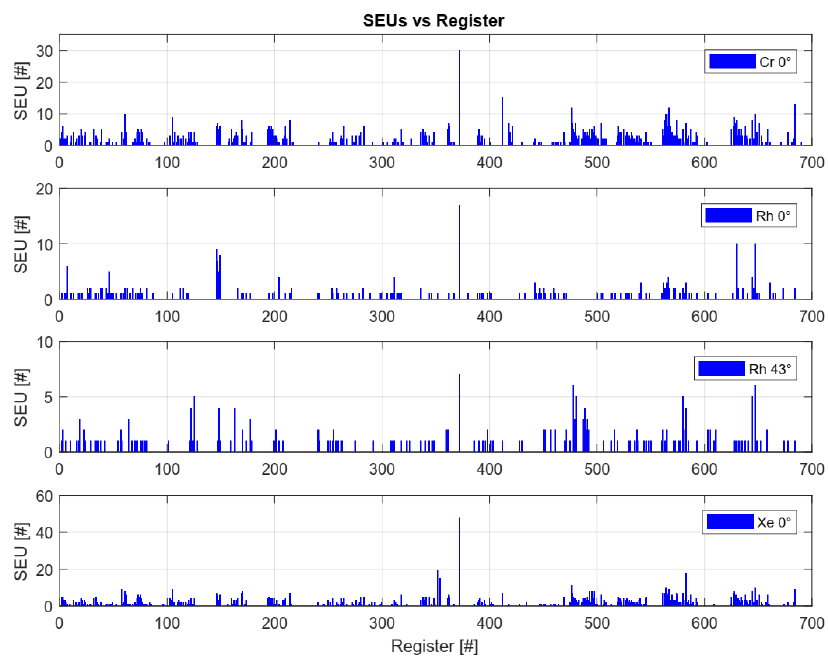
Figure 18. Accumulated SEUs vs. monitored functional registers for DUT 1 on four runs (Cr 0°, Rh 0°, Rh 43°, and Xe 0°).